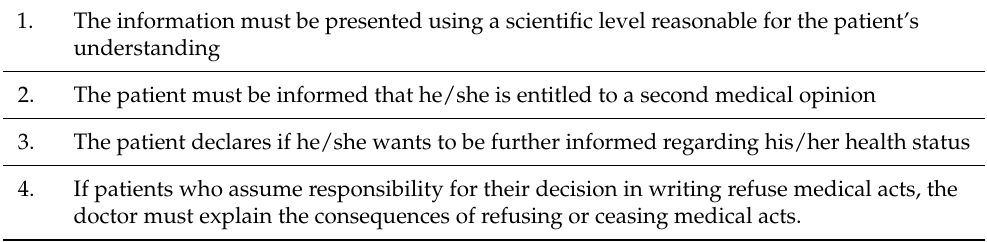
Table 2. Mandatory requirements for the informed consent